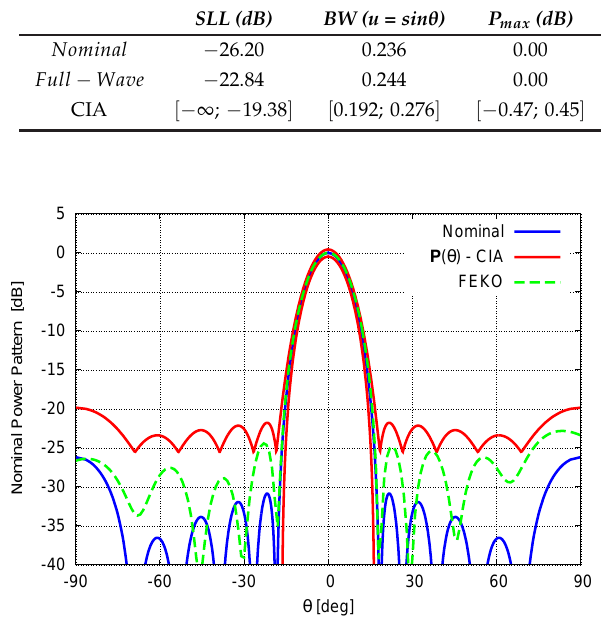
Figure 10. Full-Wave Simulation ( N = 6, d = 0.8 λ ; Dolph–Chebyshev pattern: SLL ref = − 30 dB)—Nominal Equation (19) power pattern, FEKO [27]—computed power pattern, and CIA-predicted power pattern